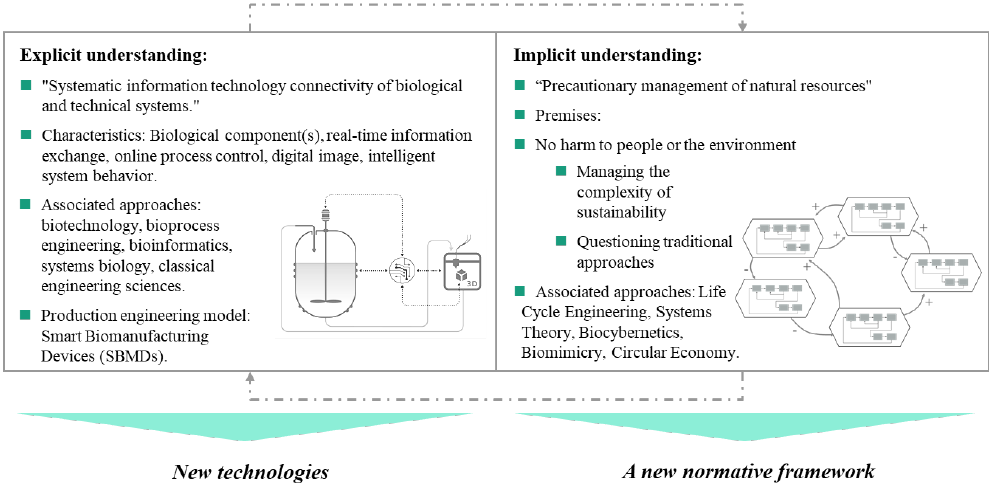
Figure 2. Distinction between explicit and implicit interpretation according to Miehe et al. [5,23].